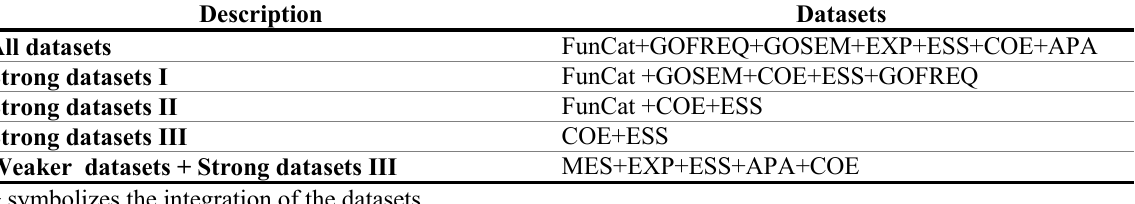
Table 3. Datasets involved in integration